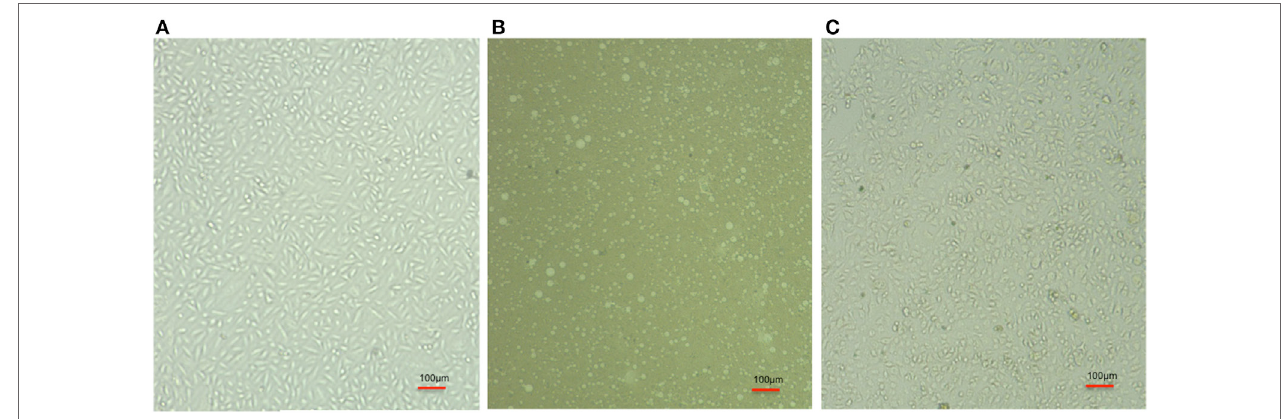
FigUre 5 | Comparative cell line image of A-549 cell line (a) , Acinetobacter baumannii infected A-549 cell line (B) , and PVP-capped silver nanoparticles-treated A. baumannii infected A-549 cell line (c) . Bulbs seen in panel (B) represent lysed A549 cell after A. baumannii infection. The triplicate experiments were performed and result of one experiment is